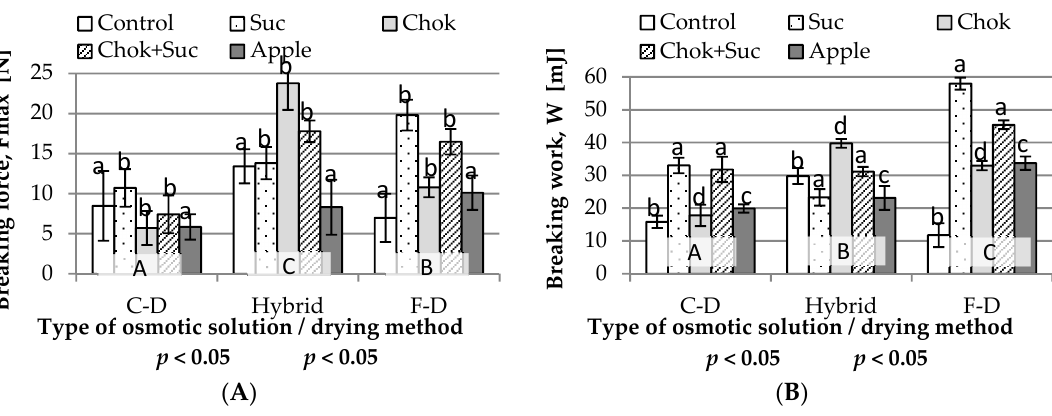
Figure 3. Influence of the type of osmotic solution and drying method on: ( A ) breaking force and ( B ) breaking work of quince chips. Designations: a–d and A–C—homogeneous groups; Suc, Chok, Chok + Suc, apple—coding the type of osmotic solution and C-D, hybrid, F-D—coding the type of drying method as given in the experimental